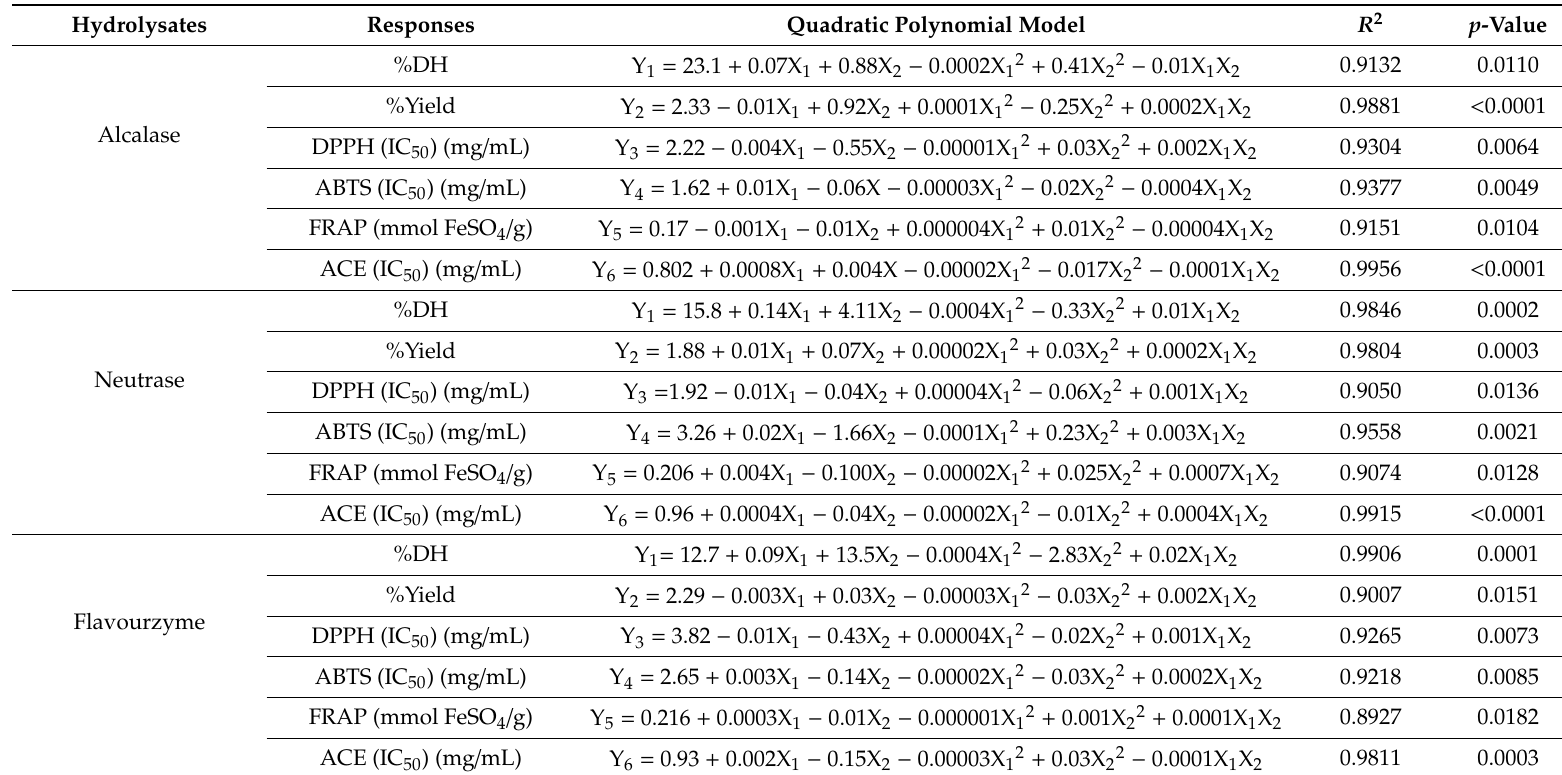
Table 2. Response surface model of TB hydrolysis using Alcalase, Neutrase and Flavourzyme.